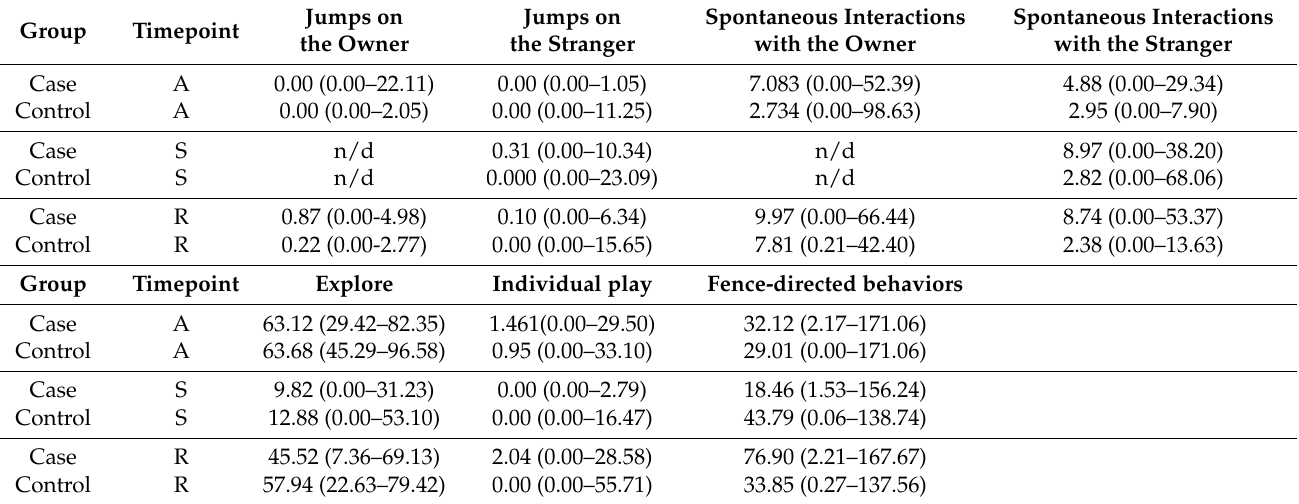
Table 2. Median duration (in percentage, minimum–maximum) of behaviors expressed by dogs across the three timepoints.